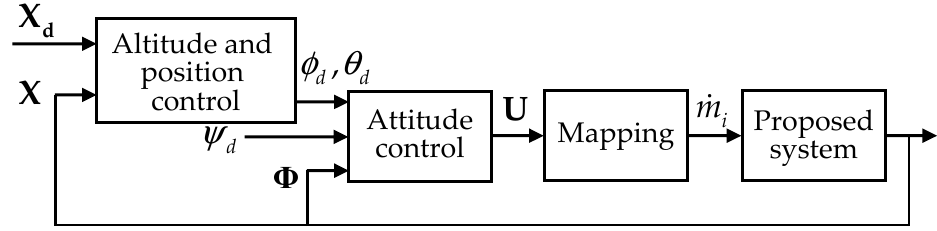
Figure 4. Block diagram of the motion control system for the flying-type firefighting system with water jet actuators.